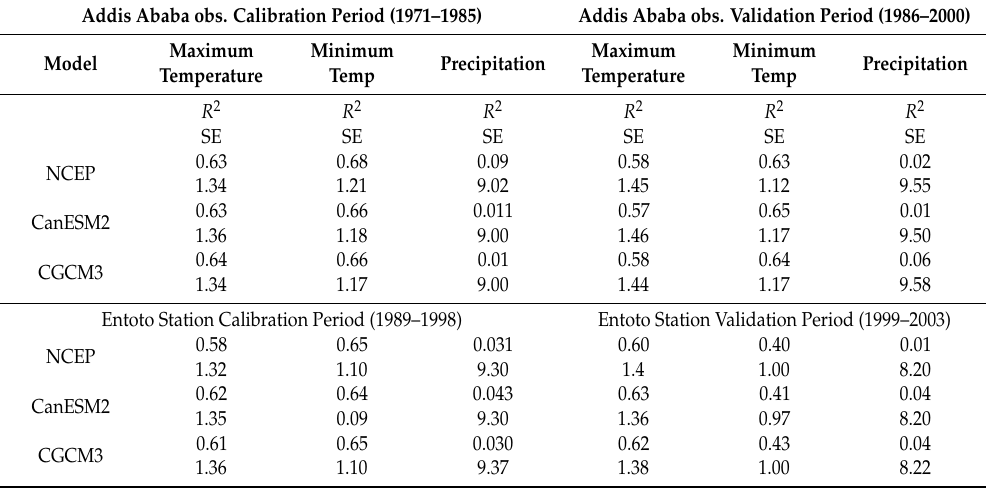
Table 3. Result of model calibration and